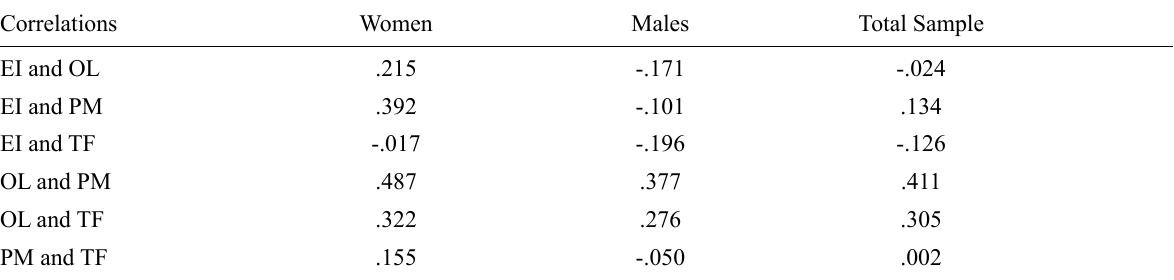
Correlations among Latent Styles of Temperament